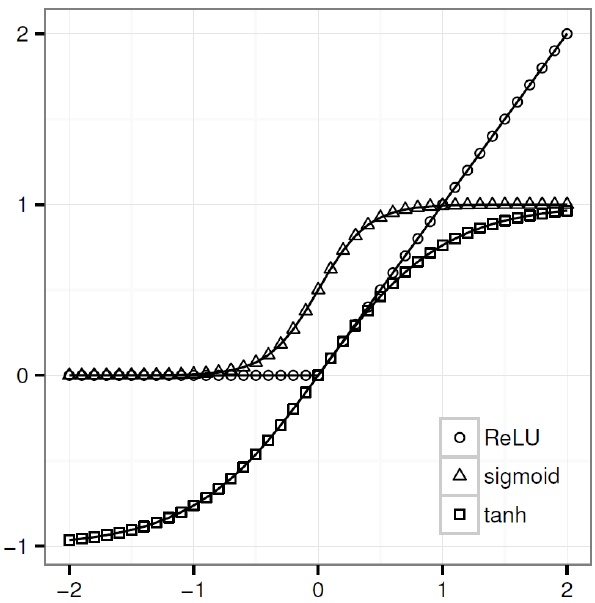
Figure B1. Illustration of sigmoid, tanh, and ReLU activation func- tions (after Zheng et al.,